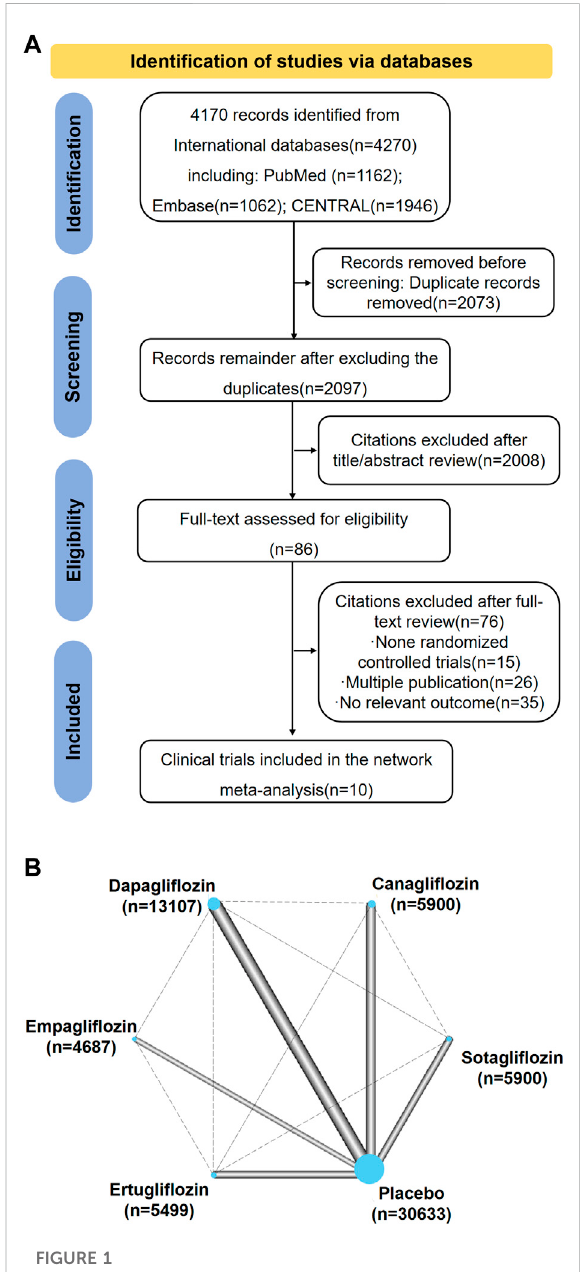
FIGURE 1 (A) Summary of Study Identi fi cation for Network Meta- analyses. (B) Network Plot for All Studies. Graphical representation of network for all induced trials. Connecting solid lines represent head-to-head comparisons between drugs, indicated by nodes. The thickness oflines betweennodes isproportionalto the number of trials comparing the treatments. The sizes of the nodes are proportional to the number of patients in each treatment which is marked below drugs. The control group is compared with each drug class. This is accounted for within the network model and does not constitute duplication of